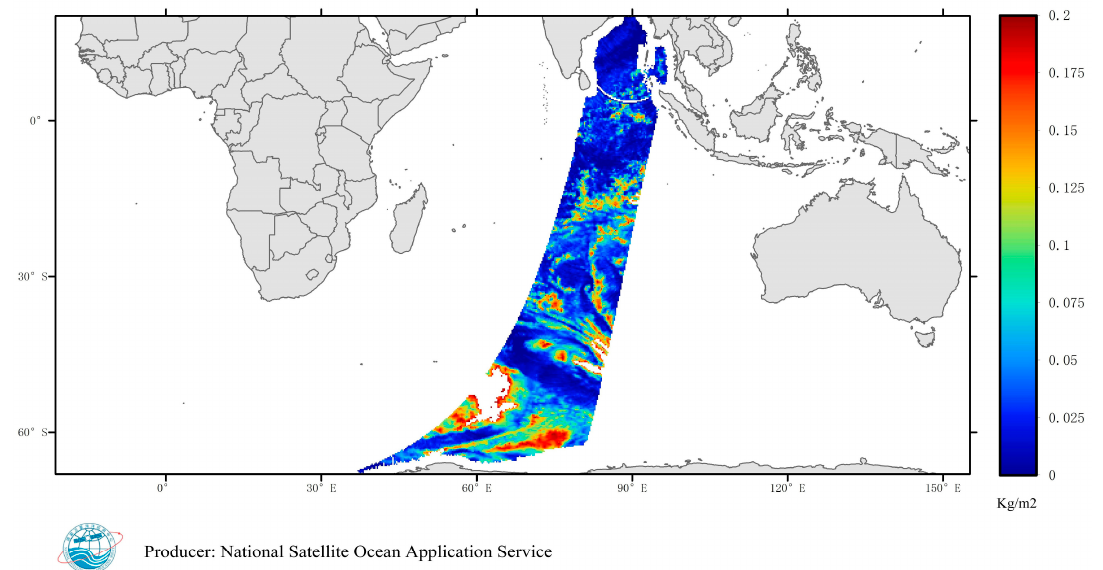
Figure 8. A Cloud Liquid Water thematic map of a single HY-2A swath for 25 March 2015 derived from the Customized Processing System. The sample points of cloud liquid water are mapped to a 0.25-degree grid. The colors show the cloud liquid water.